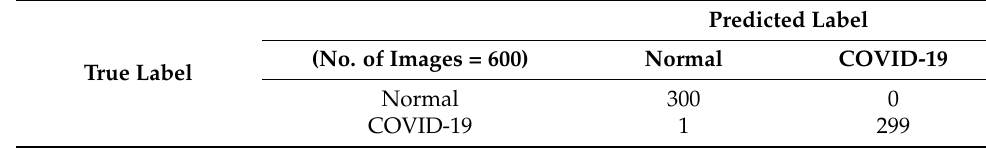
Table 4. Validation confusion matrix of DensNet169 for two-class classifier.